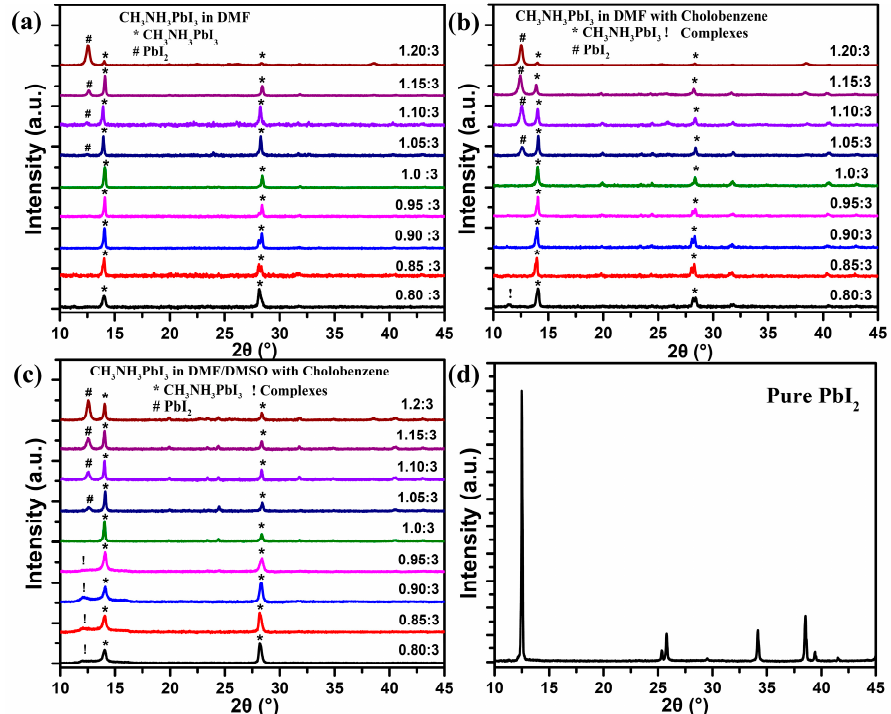
Figure 4. XRD patterns of CH 3 NH 3 PbI 3 films composed of different precursors ratios. ( a ) Precursors dissolved in DMF, and spun without any solvent dropping. ( b ) Precursors dissolved in DMF and spun with chlorobenzene dropping. ( c ) Precursors dissolved in DMF/DMSO and spun with chlorobenzene dropping. ( d ) Pure PbI 2 powders were purchased from Alfa Aesar.